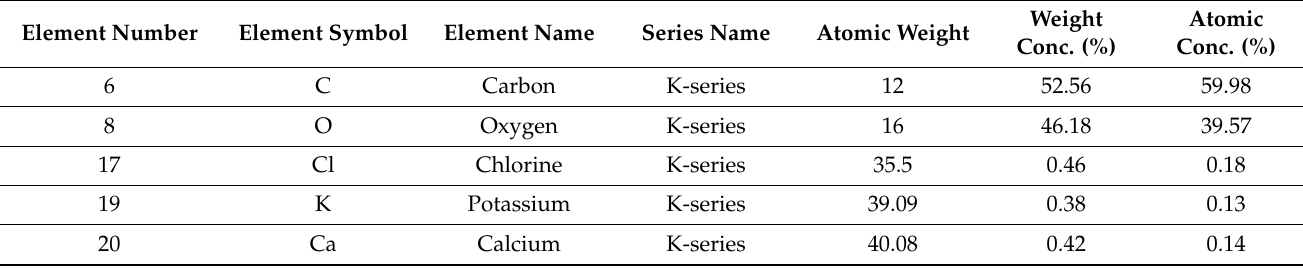
Figure 14. Spectrum analysis of the chemical structure of single sisal fiber hybrid composite fractured position obtained at an intensity of 4 keV. Table 7. Chemical structure of single sisal fiber hybrid composite at fractured